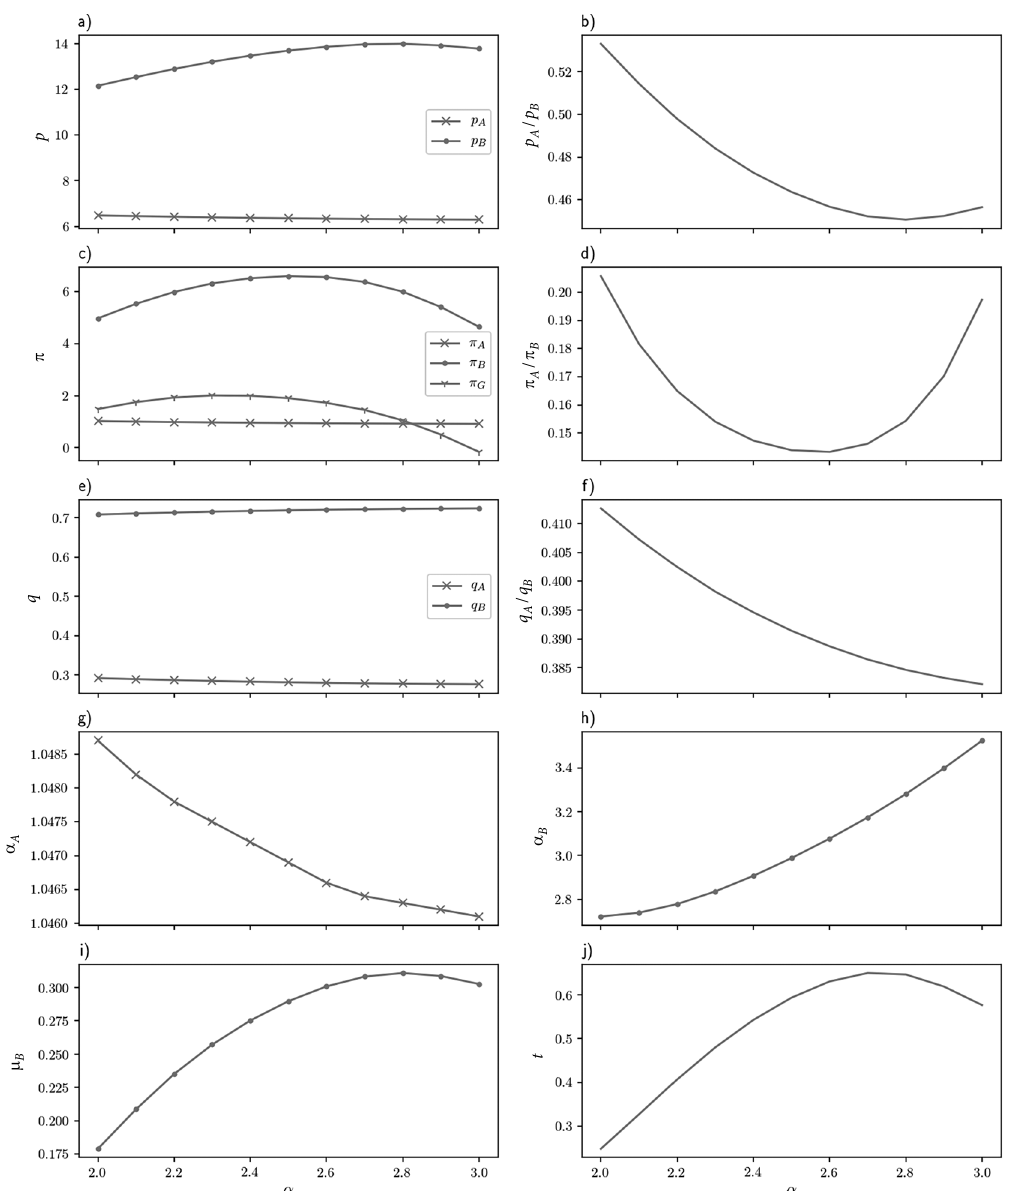
Figure 3. Plots of the dynamic changes of all the factors caused by changes in minimum assembly rate for government